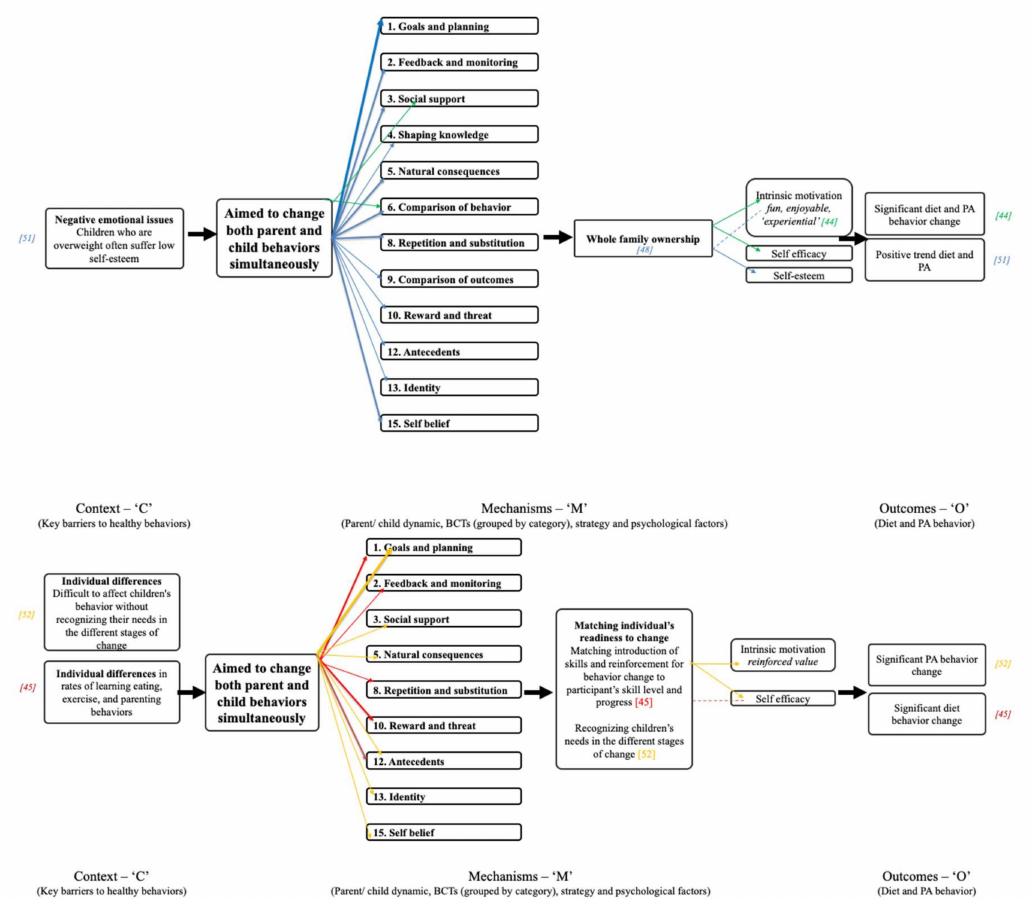
Figure 6. C-M-O patterns based on interventions aiming to change both parent and child behaviors simultaneously. Solid arrows indicate configuration between context, mechanisms and outcomes evidenced by the included studies, and dashed arrows depict those configurations that were hypothesized but not